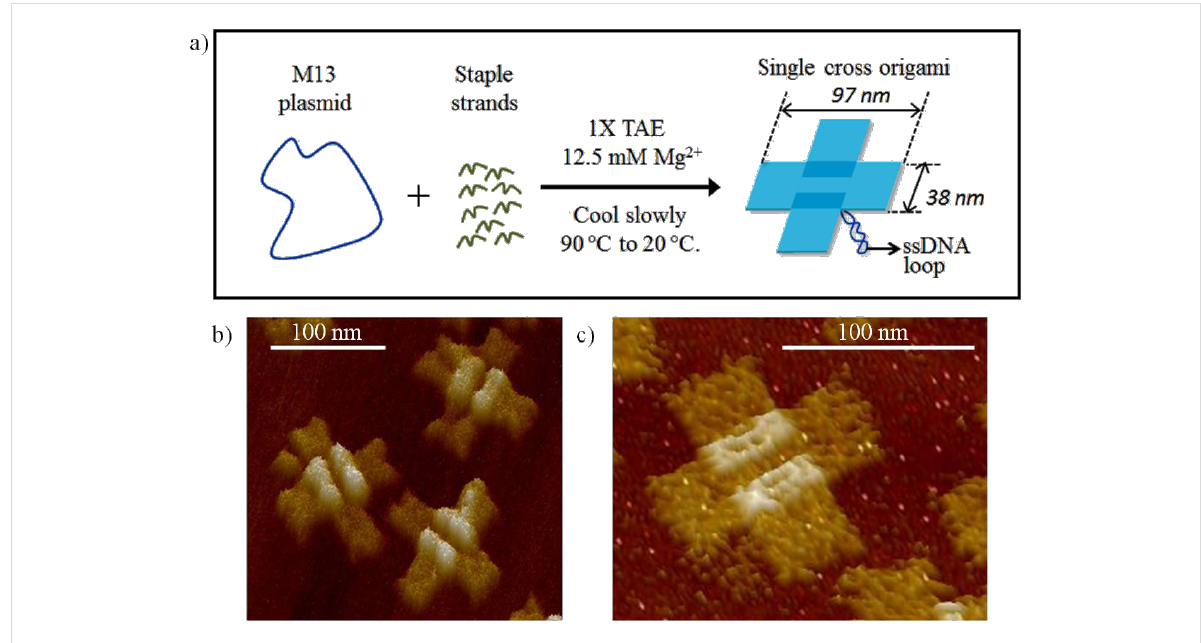
Figure 1: Schematic illustration representing (a) self-assembly of M13 plasmid (dark blue) and staple strands (deep green) to form cross shaped DNA origami (light blue); (b) and (c) represent AFM 3D images of formed DNA origami on mica. Each of the tiles forms the cross-like structure shown in (a). The 3D images of the cross-shaped DNA origami emphasize the overlap of the two